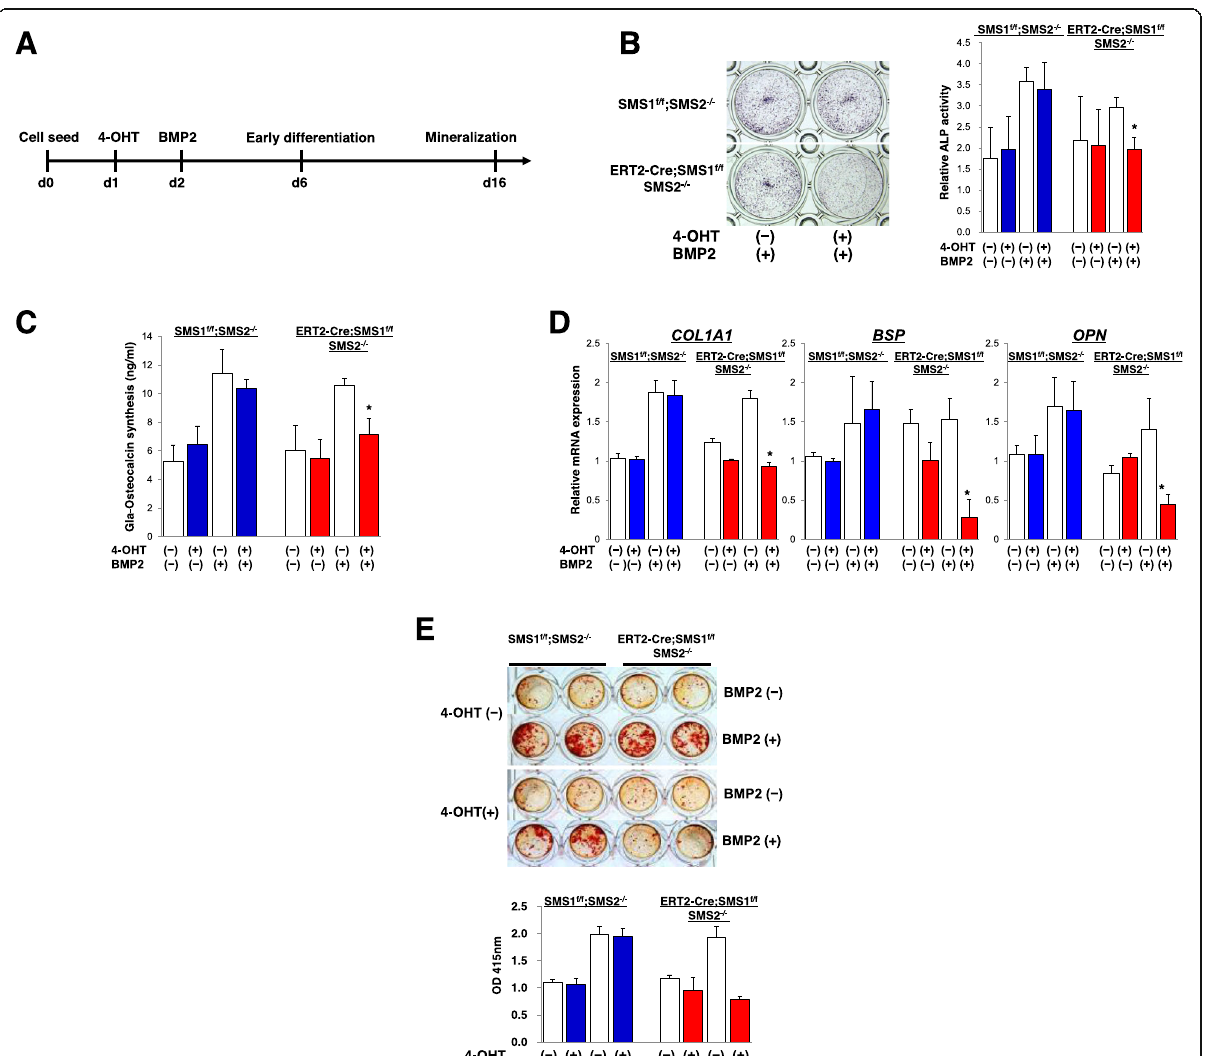
Fig. 5 Effects of SMS1 knock-out on osteoblast differentiation. a Schematic outline of the experimental design. b Representative pictures of ALP- staining of primary calvarial osteoblast cultures in the absence or presence of 1 μ M 4-OHT at day 6 after BMP2 stimulation (left). Quantification of the staining is shown (right). Inactivation of SMS1 resulted in reduced ALP activity of calvarial osteoblasts. * p < 0.005 versus SMS1 f/f ;SMS2 − / − (4- OHT+, BMP2+) and ERT2-Cre;SMS1 f/f ;SMS2 − / − (4-OHT − , BMP2+); Values are expressed as the mean ± SD, n = 8. c Gla-Osteocalcin contents of primary calvarial osteoblast cultures in the absence and presence of 4-OHT at day 6 after BMP2 stimulation. * p < 0.005 versus SMS1 f/f ;SMS2 − / − (4-OHT+, BMP2+) and ERT2-Cre;SMS1 f/f ;SMS2 − / − (4-OHT − , BMP2+); Values are expressed as the mean ± SD, n = 6. d After treatment with and without 1 μ M 4- OHT for 1 day, SMS1 f/f ;SMS2 − / − and ERT2-Cre;SMS1 f/f ;SMS2 − / − mice calvarial osteoblasts were cultured with and without 100 ng/ml BMP2 in α -MEM with 10% FBS containing 50 μ g/ml ascorbic acid, 10 mM β -glycerophosphate for 4 days. Col1a1 , BSP and OPN mRNA levels were normalized to GAPDH mRNA. Treatment with 4-OHT does not affect the differentiation of primary SMS1 f/f ;SMS2 − / − calvarial osteoblasts. * p < 0.005 versus SMS1 f/f ;SMS2 − / − (4-OHT+, BMP2+) and ERT2-Cre;SMS1 f/f ;SMS2 − / − (4-OHT − , BMP2+); Values are expressed as the mean ± SD, n = 8. e Decreased bone nodule formation in the 4-OHT-induced SMS1 inactivation. Representative images of nodule mineralization stained with Alizarin red. SMS1 f/f ;SMS2 − / − and ERT2-Cre;SMS1 f/f ;SMS2 − / − mice calvarial osteoblasts were treated with and without 1 μ M 4-OHT for 1 day, and cultured with and without 100 ng/ml BMP2. On day 17, the cells were stained with Alizarin red (upper). Quantification of the staining is shown (lower). * p < 0.005 versus SMS1 f/f ;SMS2 − / − (4-OHT+, BMP2+) and ERT2-Cre;SMS1 f/f ;SMS2 − / − (4-OHT − , BMP2+); Values are expressed as the mean ± SD, n =